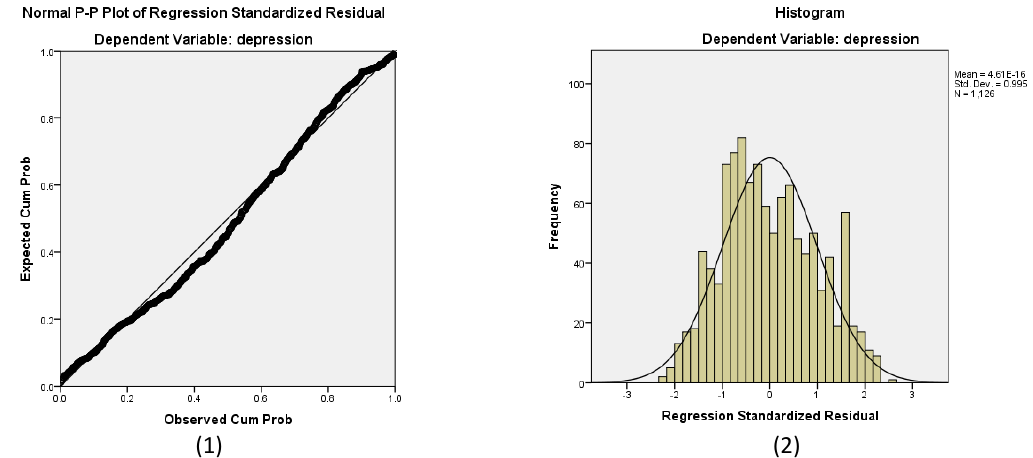
Figure 1. P-P Plot (1) and histogram (2) residual normality test results Table 1. Demographical factors